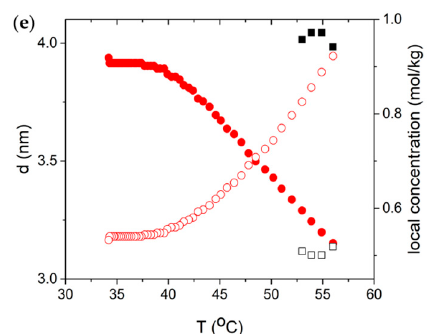
Figure 4. Temperature dependence of lateral distance d (left axis, closed symbol) and local concentration c (right axis, open symbol). Red circles correspond to C phase, blue triangles to N phase, and black squares to I phase. ( a ) DSCG 0.34 mol/kg + PEG 0.011 mol/kg; ( b ) DSCG 0.34 mol/kg + PEG 0.022 mol/kg; ( c ) DSCG 0.49 mol/kg; ( d ) DSCG 0.65 mol/kg; ( e ) DSCG 0.80 mol/kg.